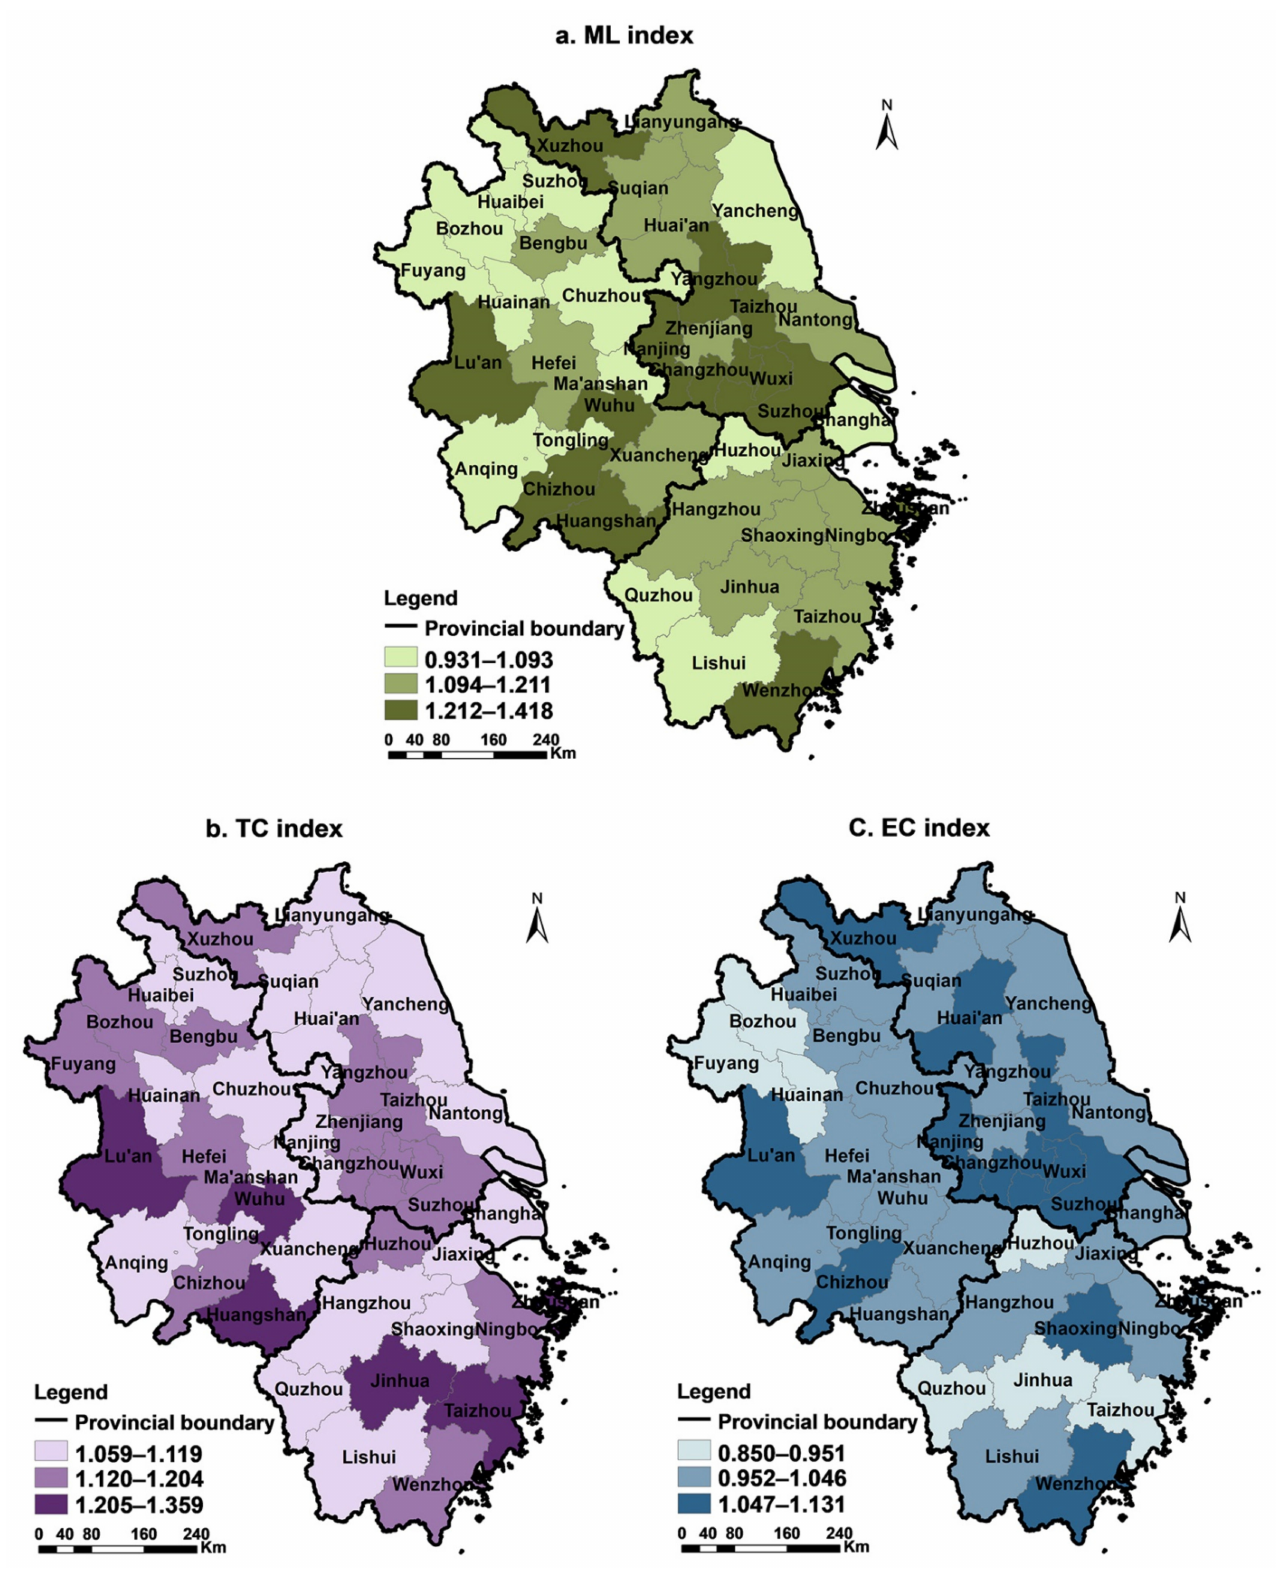
Figure 5. Annual average values of ML, TC, and EC of urban construction land in the Yangtze River Delta. ( a ) The spatial distribution of ML index; ( b ) spatial distribution of TC index; ( c ) spatial distribution of EC index. (1) As the largest cities in the region, Suzhou, Wuxi, and Changzhou, among